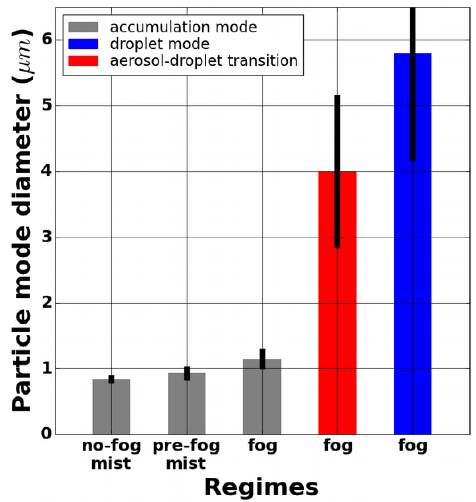
Figure 10. Monthly averages of the particle mode diameter derived from the WELAS data, for different regimes: accumulation mode in mist and in fog (grey), and droplet mode in fog (blue), as well as the aerosol–droplet transition diameter (red). Vertical thick lines depict the standard